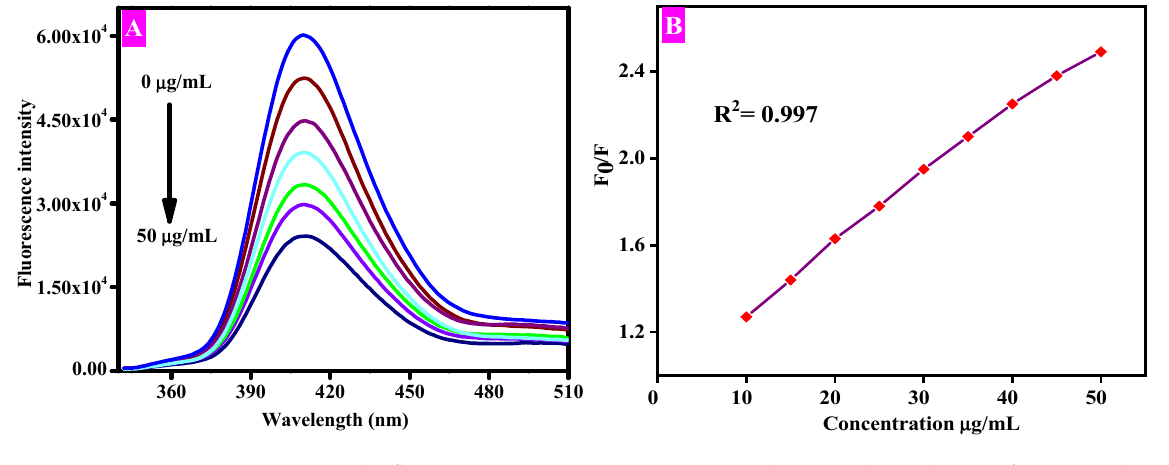
Figure 8. The fluorescence emission response ( A ) and Stern–Volmer plot ( B ) of compound 4d (10 µM) towards the addition of increasing concentrations of DNA (0 ‒ 50 µg/mL) in DMF/H 2 O (1:9, v / v ); (excitation wavelength ( λ exc ) = 280 nm, slit width = 2/2).